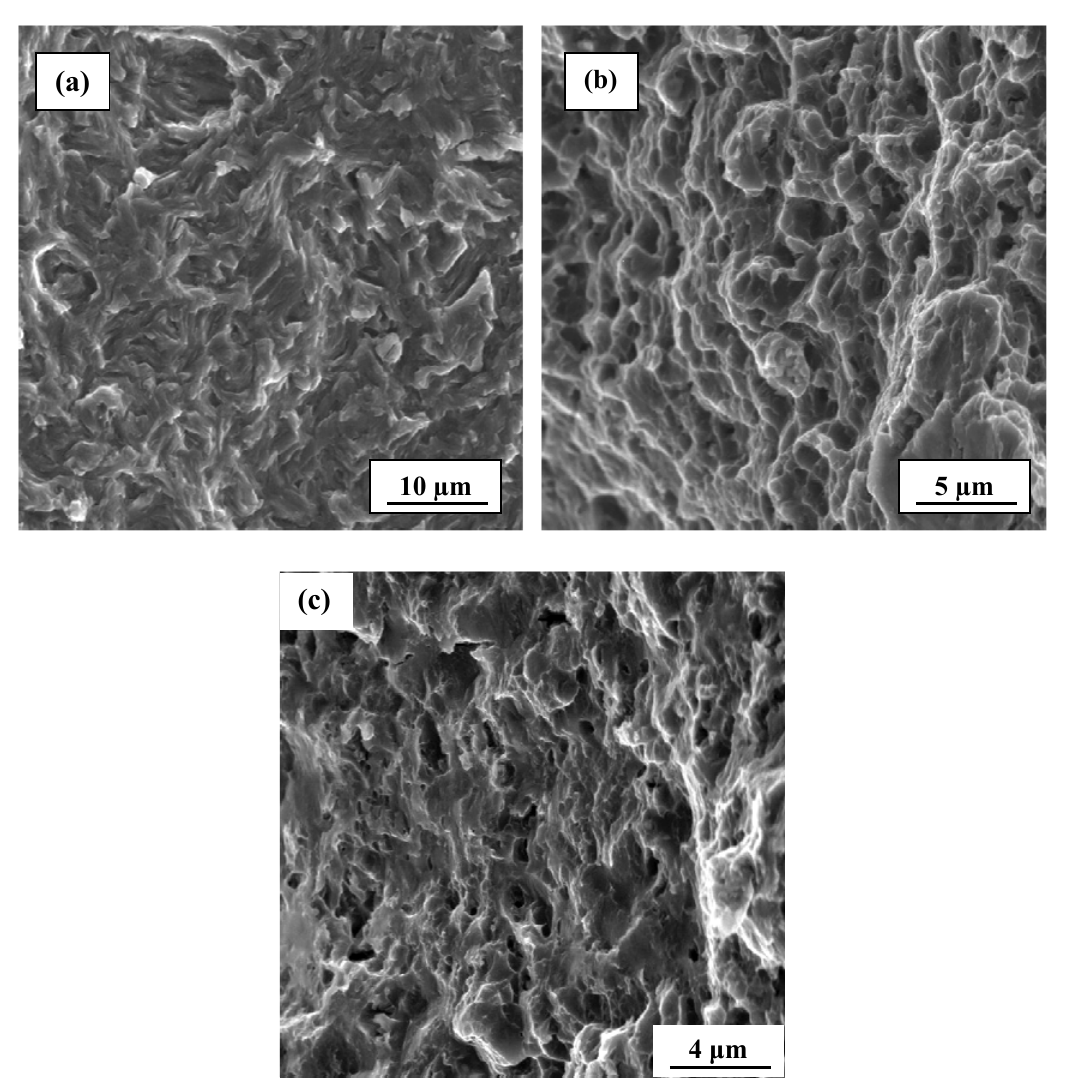
Figure 10. Scanning electron micrographs of the high cycle fatigue fracture surface of AZ31 deformed at maximum cyclic stress of 152.72 MPa at load ratio of 0.1, fatigue life of 32,940 cycles, showing the following: ( a ) Transgranular fracture in the region of early crack growth; ( b ) Shallow dimples of varying size and shape covering the region of overload fracture surface and ( c ) High magnification observation of the region of crack initiation and early microscopic growth showing a random distribution of fine microscopic